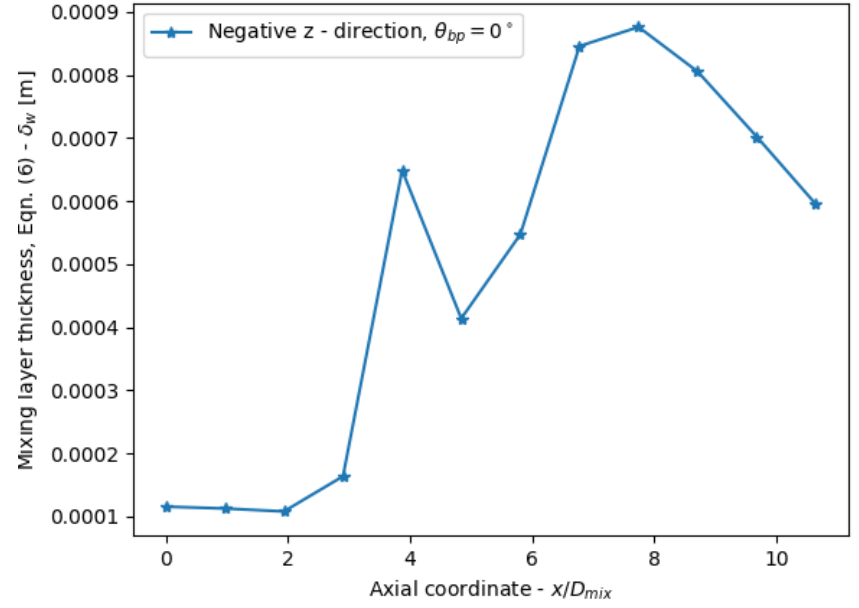
Figure 13. Mixing layer thickness along the mixing-chamber center line without a bypass